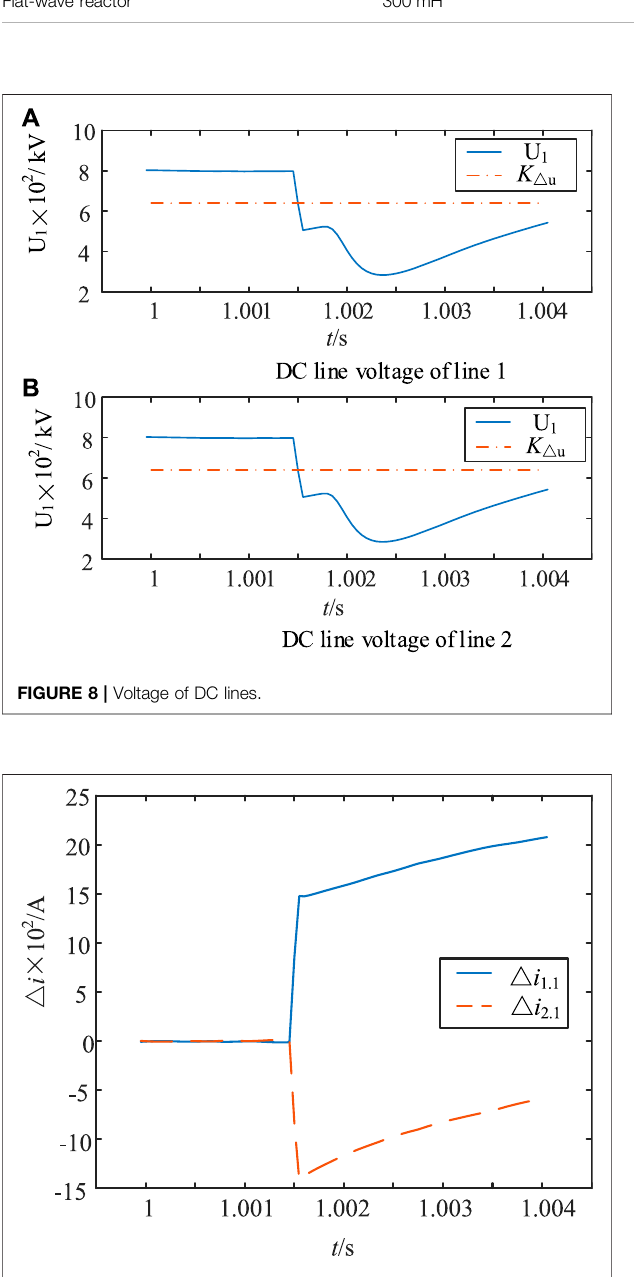
FIGURE9| Suddenchangeamountofthefaultcurrentlinemodecomponent.